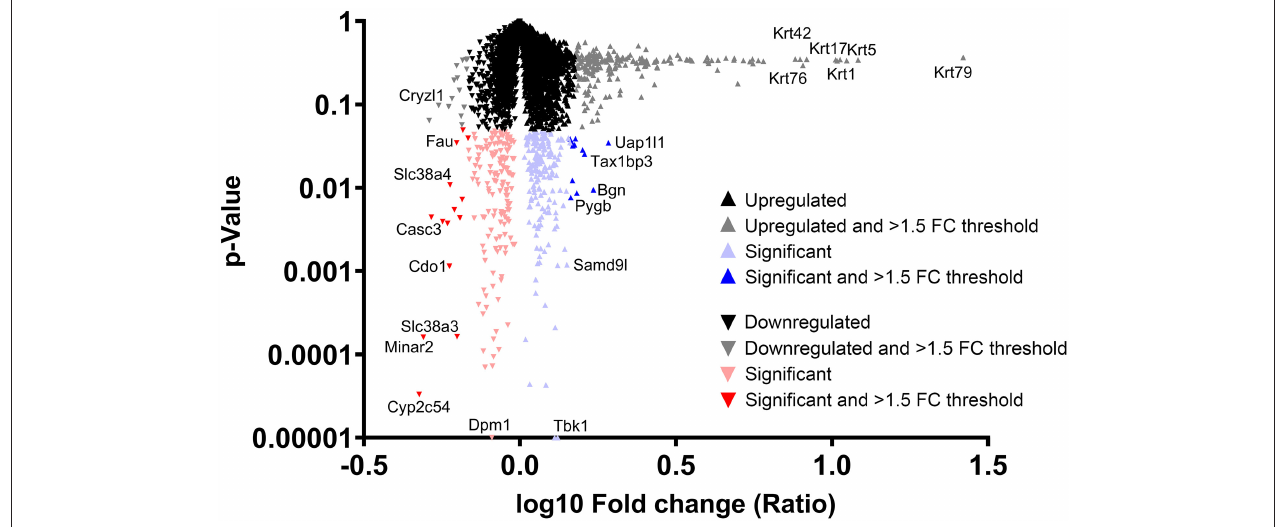
FIGURE 4 | Distribution of proteins upregulated or downregulated in response to Aquamin ® compared to high-fat control. Value for each protein (group average) in the high-fat control was set to 1.0 and values in the Aquamin ® group were compared to this. The x-axis shows the fold-change (log10) of individual proteins and the y-axis reflects individual protein p -values ( N = 5 individual liver samples per group). The mass of proteins shown in black represent proteins that were < 1.5-fold different from control (up or down) and not statistically significant. Proteins depicted with gray were different from control by 1.5-fold or greater but not statistically different. Red triangles represent down-regulated proteins and blue triangles represent up-regulated proteins that were statistically significant as compared to control. Bold color (red or blue) represents proteins that were both statistically different from control and different from control by 1.5-fold or greater. Certain individual proteins are identified by UniProt protein (gene) symbol.